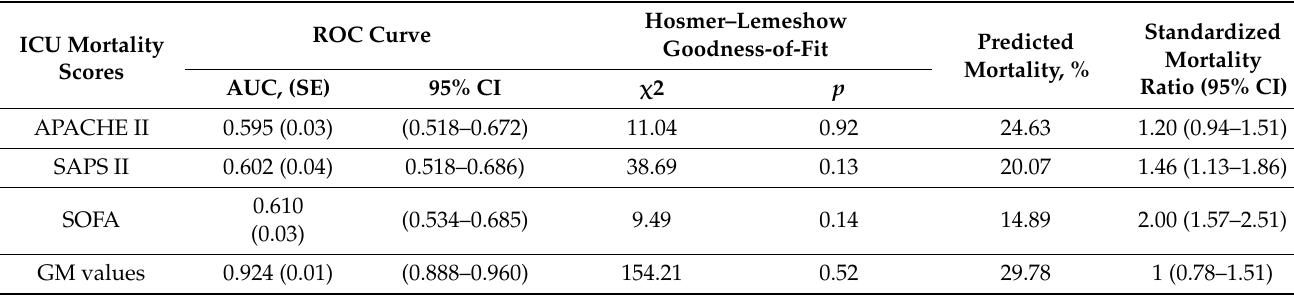
Table 5. Area under the receiver operating characteristic (ROC) curve, Hosmer–Lemeshow goodness-of-fit statistics, and predicted and standardized mortality ratios.